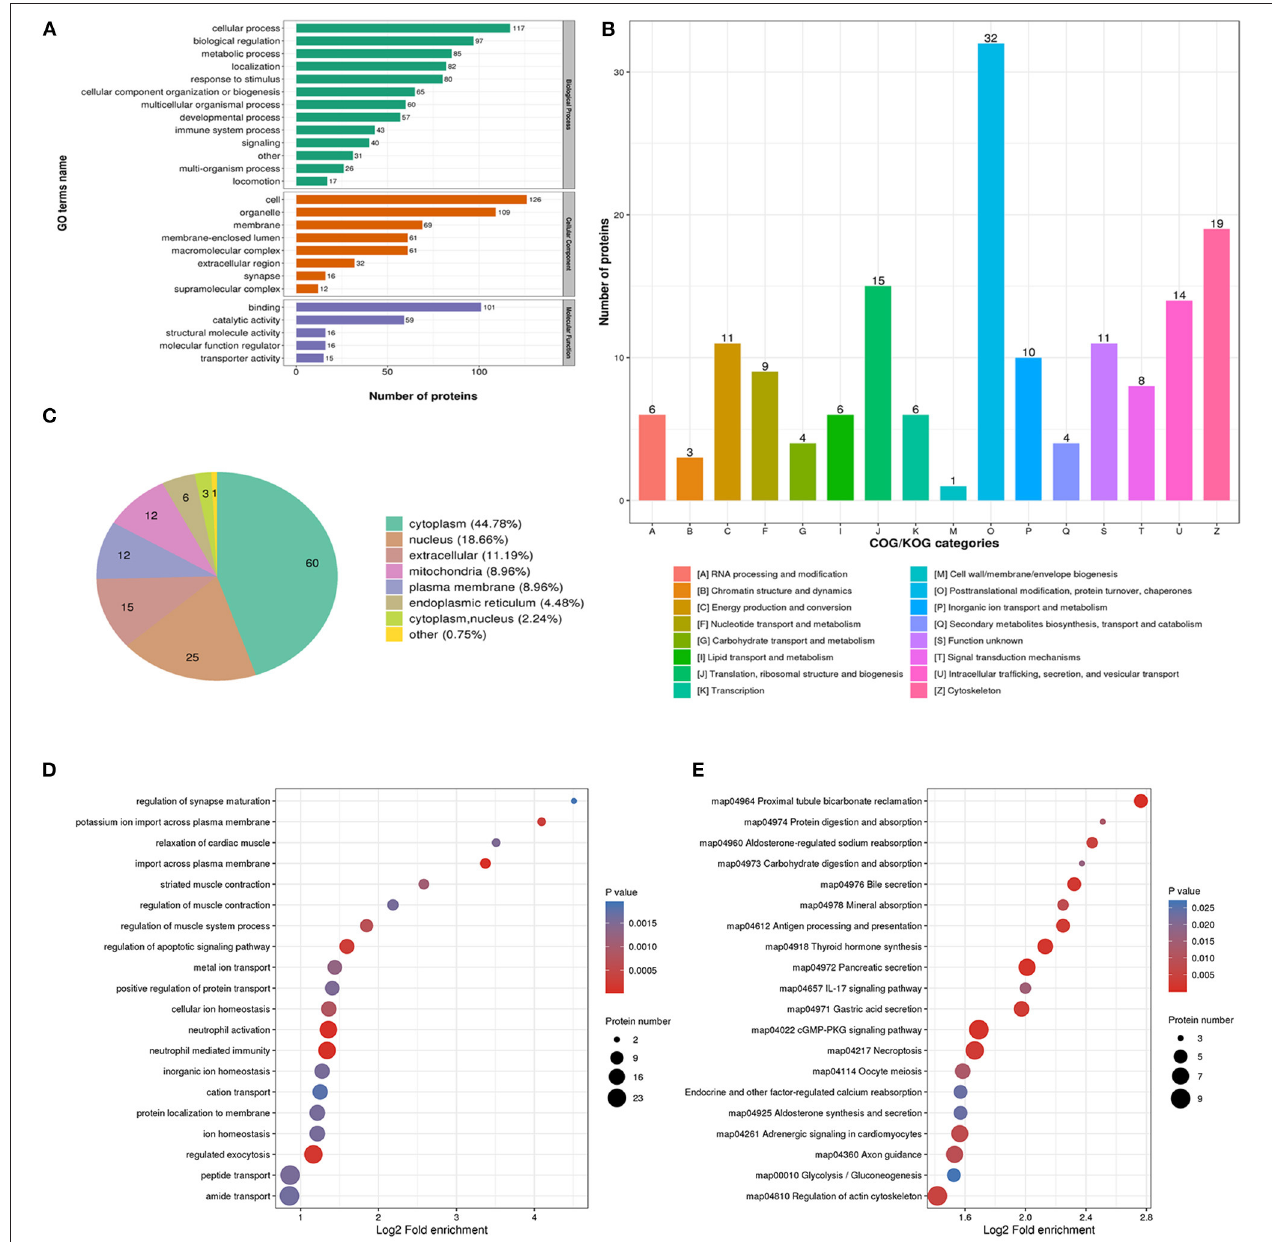
FIGURE 3 | Characterization and functional enrichment analysis of identified downregulated acetylated proteins in glioma-associated seizure. (A) The classification of downregulated acetylated proteins in biological process, cell components, and molecular function. (B) The categories of downregulated acetylated proteins in COG/KOG categories. (C) The distribution of downregulated acetylated proteins in subcellular localization. Downregulated acetylated proteins in glioma with seizures were classified by GO annotation based on (D) biological process and (E) the KEGG pathway